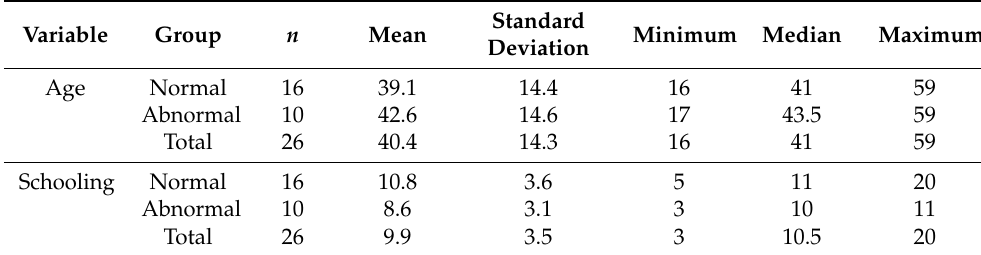
Table 1. Descriptive statistics for age (years) and education (years) in the Normal and Abnormal BAEPs groups.